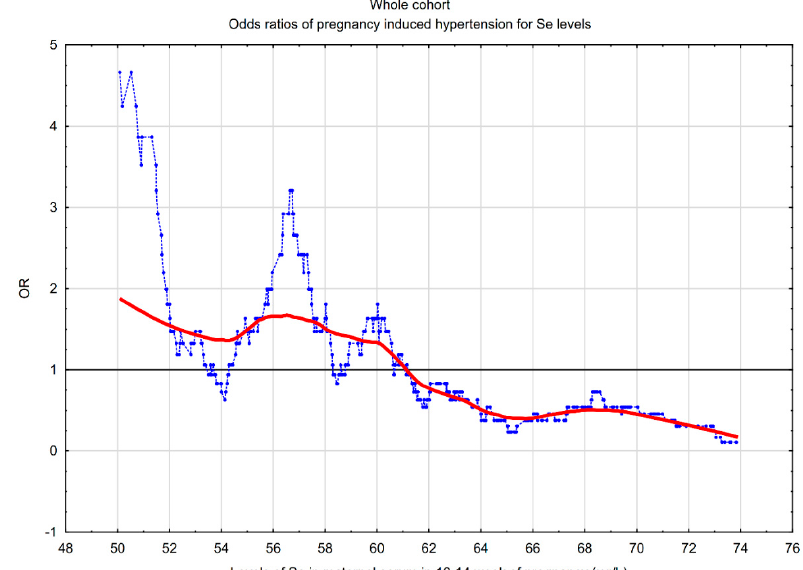
Figure 1. The risk of pregnancy-induced hypertension for selenium levels in the 10–14th pregnancy week in the whole cohort. The graph illustrates the changes in the odds ratios (OR) of pregnancy-induced hypertension (PIH), calculated on a sliding window with respect to the changes in the Se levels in serum in the 10–14th pregnancy week. The window width adopted was 50 observations. The (light blue) points correspond to the odds ratios of pregnancy-induced hypertension in a window containing a fixed number of neighboring cases whose center is for a Se level value. The (red) curve represents the risk profile smoothed with the Lowess method. The horizontal (black) line marks is the reference line for OR = 1.0; the points above this line indicate an increased risk, and the points below this line correspond to a reduction in